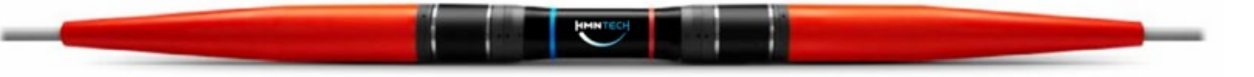
Figure 16. First-generation sectioned submerged repeater for TAT-1 the first transatlantic telephone cable [1].